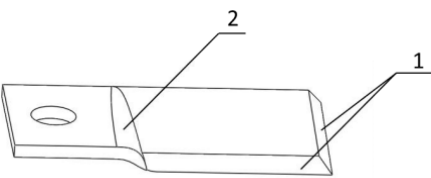
Figure 9. Schematic diagram of a twin-blade twist cutter. 1, Cutting edge; 2, Torsion position.